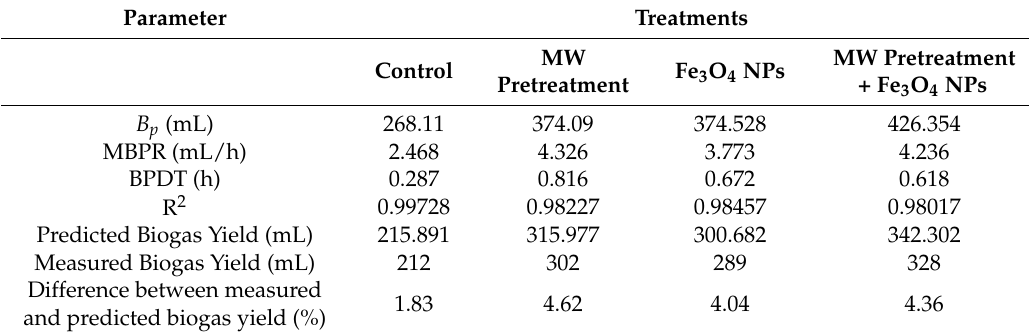
Table 3. Kinetic Parameters from the Modified Gompertz Model.